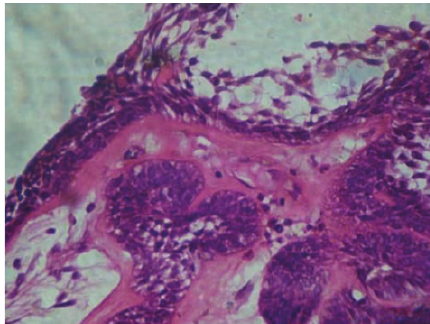
Figure 5: Suprabasal layer resembles stellate reticulum proliferating intraluminally with few vacuolated cells. (H and E)